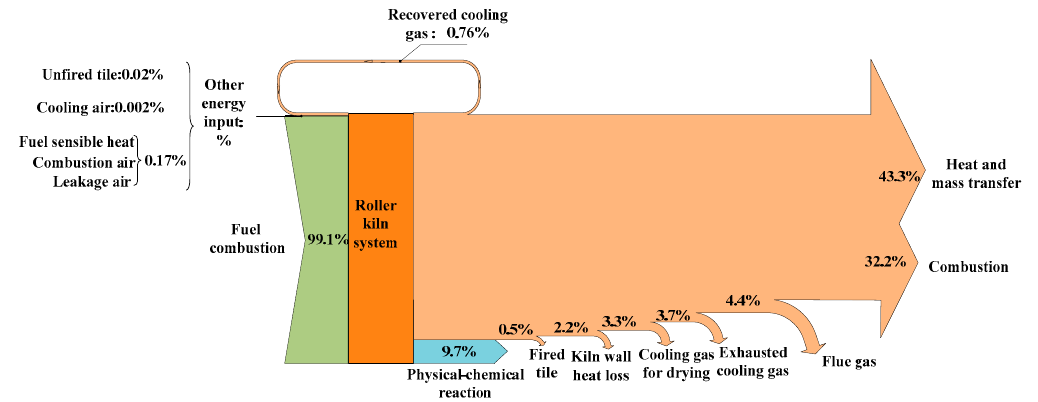
Figure 6. Grassmann diagram of the roller kiln.